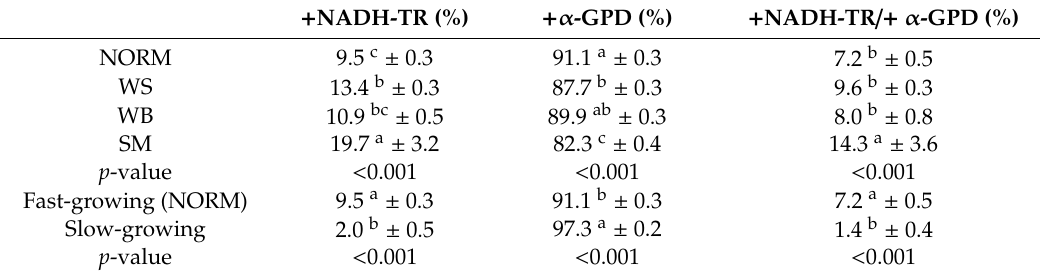
Table 1. Number of fibers (expressed as percentage) positively stained to reduced nicotinamide adeninedinucleotidetetrazoliumreductase(NADH-TR)and / oralpha-glycerophosphatedehydrogenase ( α -GPD) in pectoralis major muscles belonging to a fast-growing genotype exhibiting either macroscopically normal appearance (NORM) or a ff ected by white striping (WS), wooden breast (WB), or spaghetti meat (SM) abnormalities. The results obtained in fast-growing NORM muscles were also compared with those found in pectoralis major belonging to a slow-growing genotype. Values are expressed as mean ± standard error of the mean (SEM).